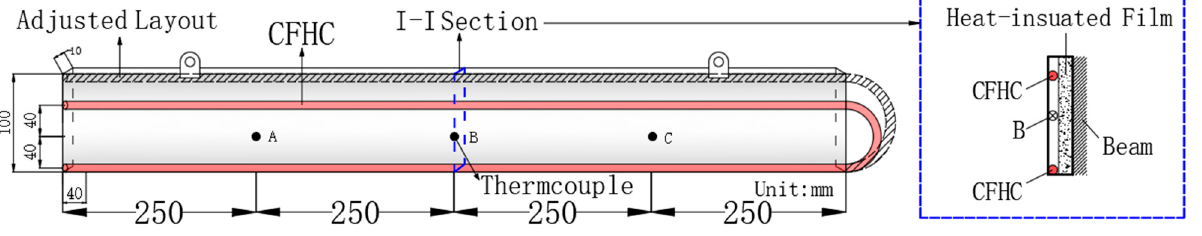
Figure 8. The internal details and size information of the heating system: the arrangement of the CFHC and thermocouples.